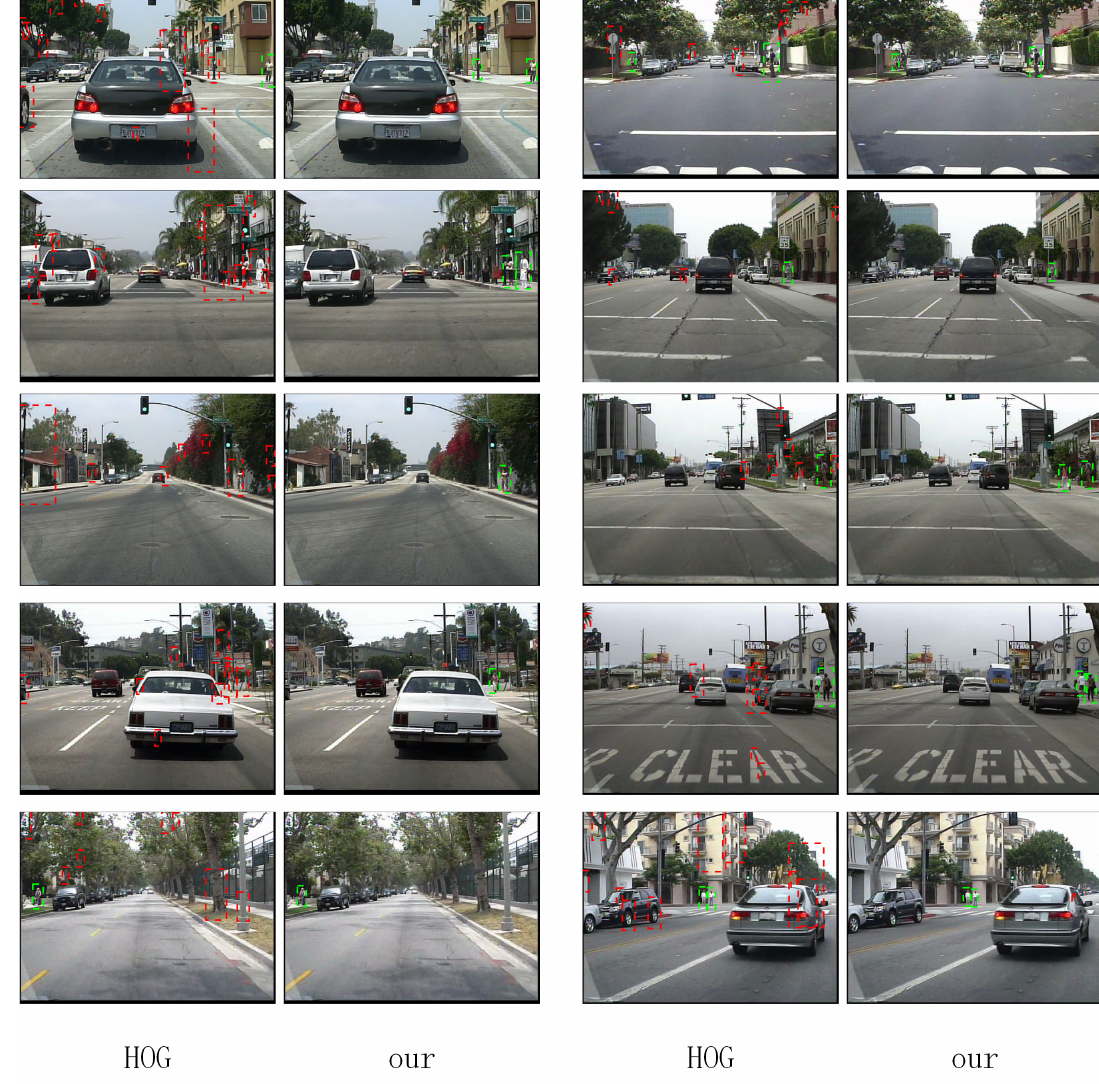
Figure 9. Results of HOG + SVM and our